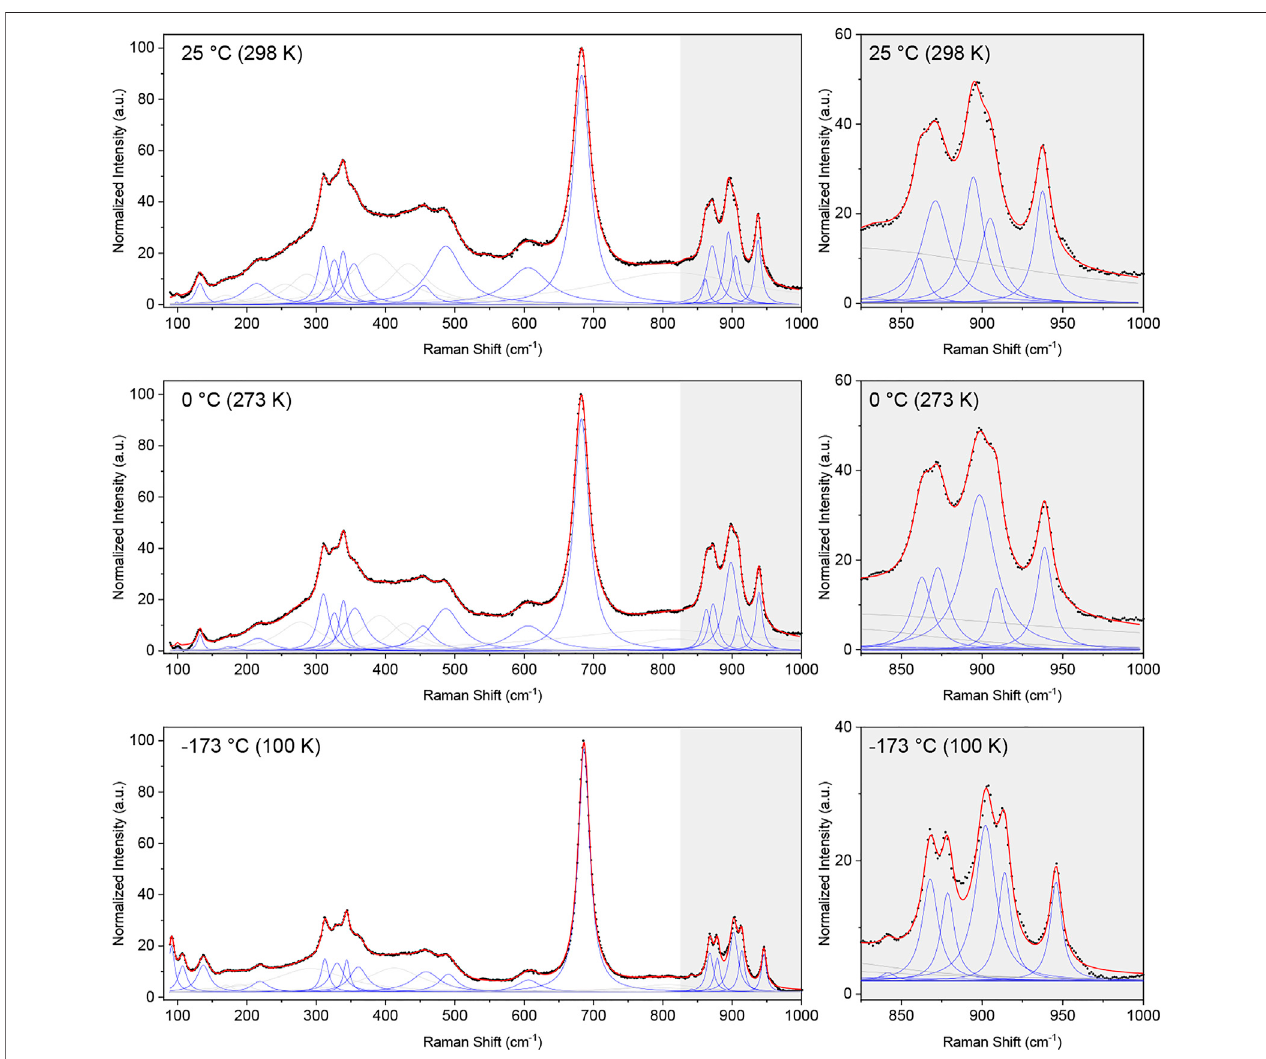
FIGURE 5 | Normalized Raman spectra corrected for the Bose-Einstein population factor (black dots) and cumulative fi t (red line) of a sum of Lorentzian functions (blue and grey) to the Raman spectra collected at 298 K (25 ° C), 273 K (0 ° C) and 100 K ( − 173 ° C). The broader Lorentzian peaks, which do not describe a de fi ned peak but contribute to the description of the background are shown in grey, whereas peaks describing clearly visible peaks are shown in blue. An enhancement of the region between 825 and 1,000 cm -1 is given for each temperature, emphasizing the narrower nature of the peaks at lower temperatures.